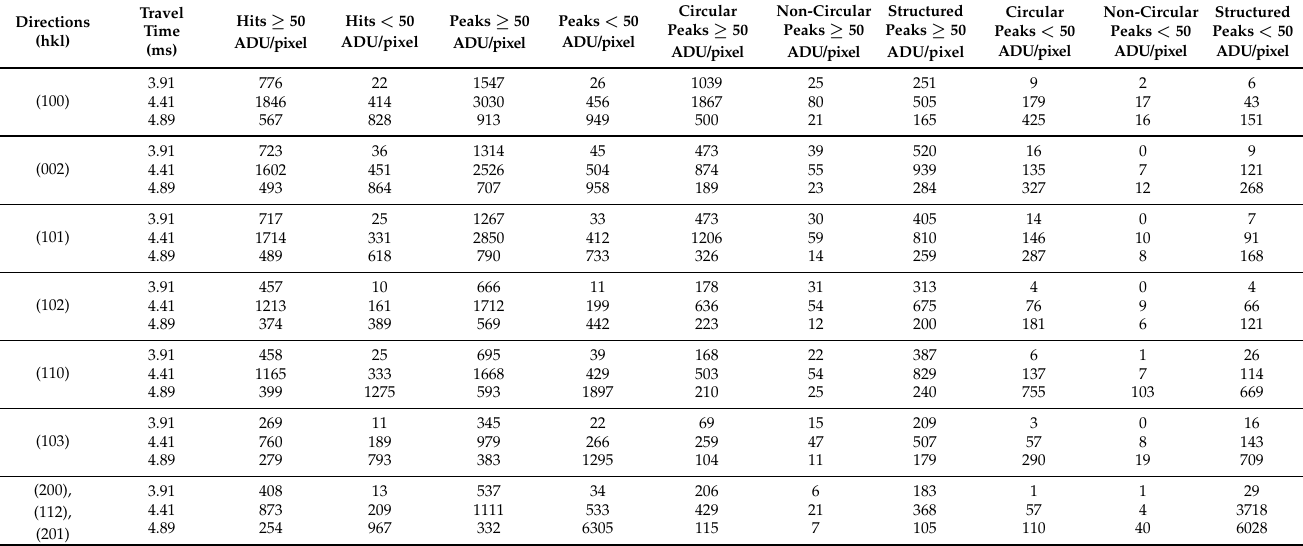
Table 2. Peak statistics for different crystal reflections of hexagonal ice for both strong ( ≥ 50 ADU/pixel) and weak ( < 50 ADU/pixel) hits and different travel times. The statistics of the number of peaks for three different classes of Bragg peaks (circular, non-circular and structured peaks) are also